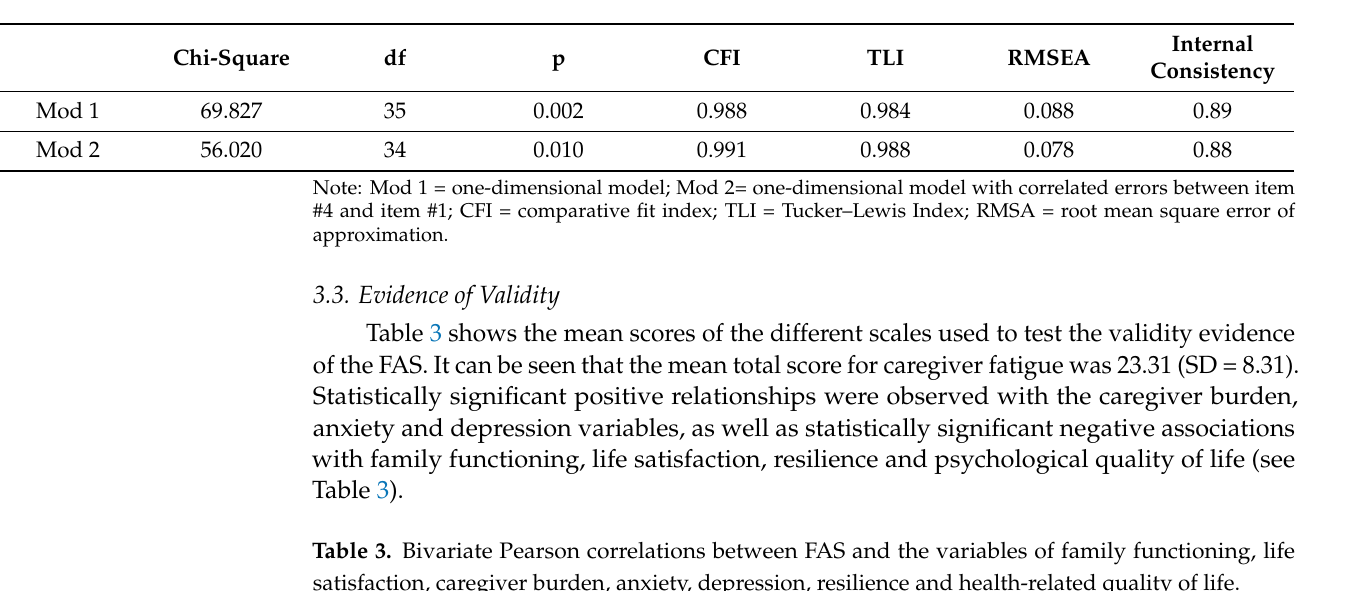
Table 2. Results of the confirmatory factor analysis ( n = 108).